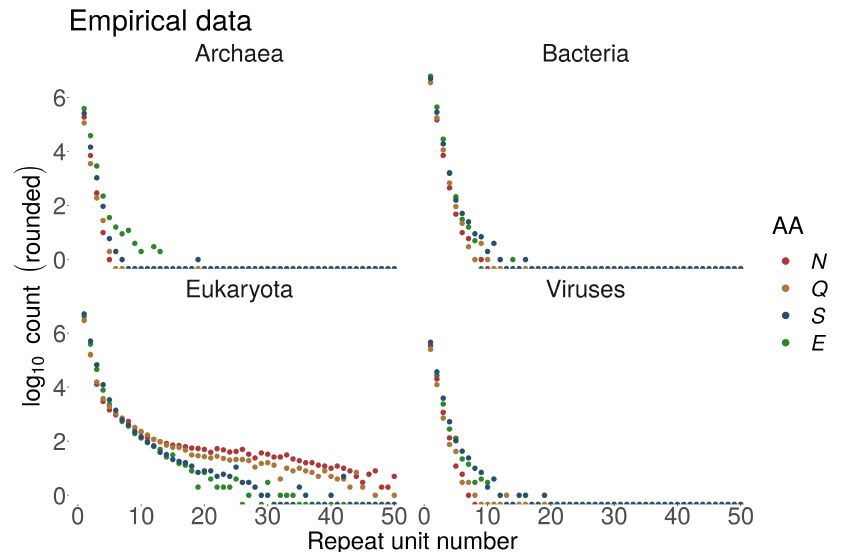
Figure 3. Absolute numbers of homorepeats in UniprotKB/Swiss-Prot in four superkingdoms for different number of repetitions ( n ≤ 50, equivalent to repeat length) for hydrophilic Asparagine (N), Glutamine (Q), Serine (S) and Glutamic acid